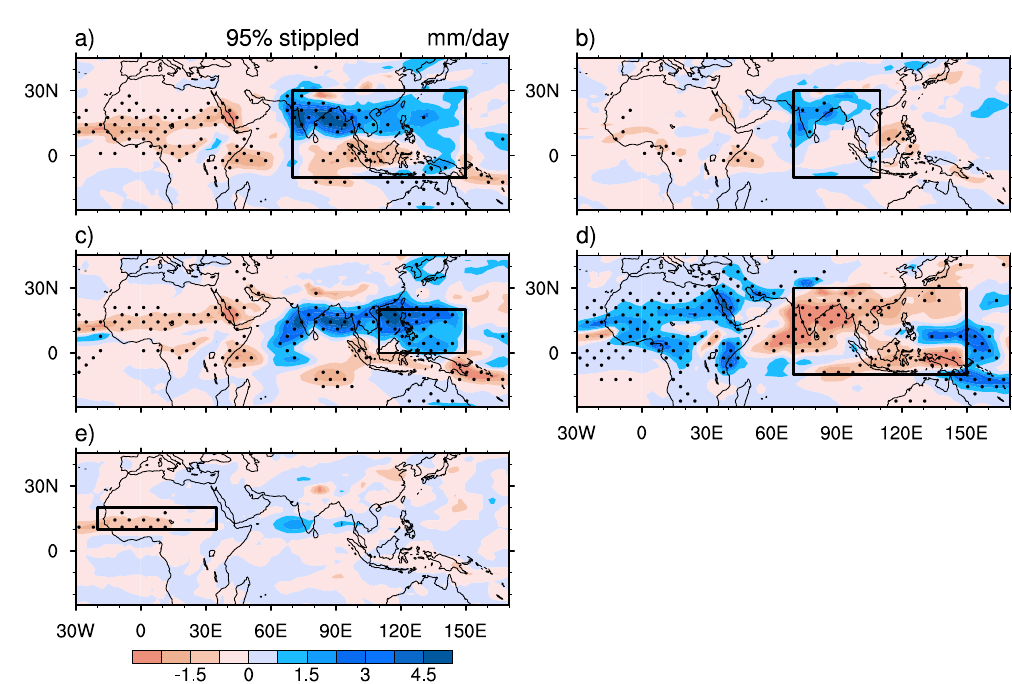
Figure 2. Differences in JAS precipitation. ( a ) Between SEN_A and CON, ( b ) between SEN_W and CON, ( c ) between SEN_E and CON, ( d ) between SEN_COOL1 and CON, and ( e ) between SEN_COOL2 and CON. The boxes define the anomalous heating regions for sensitivity experiments. The stippled area denotes the region where the change significantly exceeds the 95% confidence level (Student’s t -test). This figure was generated by the NCAR Command Language (Version 6.3.0) [Software]. (2016). Boulder, Colorado: UCAR/NCAR/CISL/ TDD.